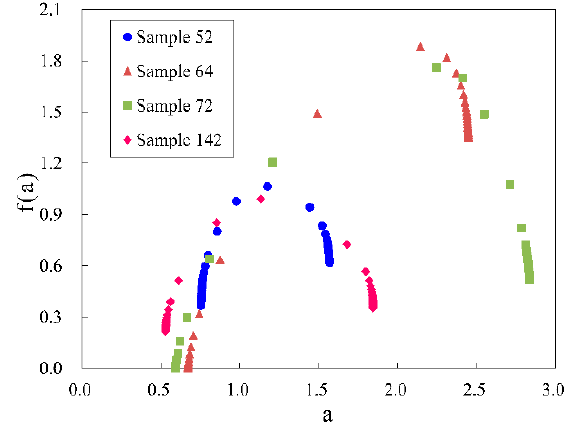
Figure 7. Plot of multifractal spectrum f ( a ) versus the singularity strength a . Table 5. Multifractal spectrum parameters obtained from the 13